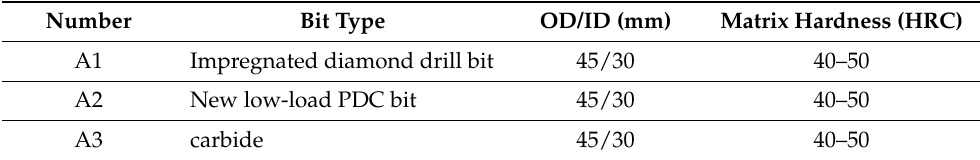
Table 3. Parameters of tested diamond drill